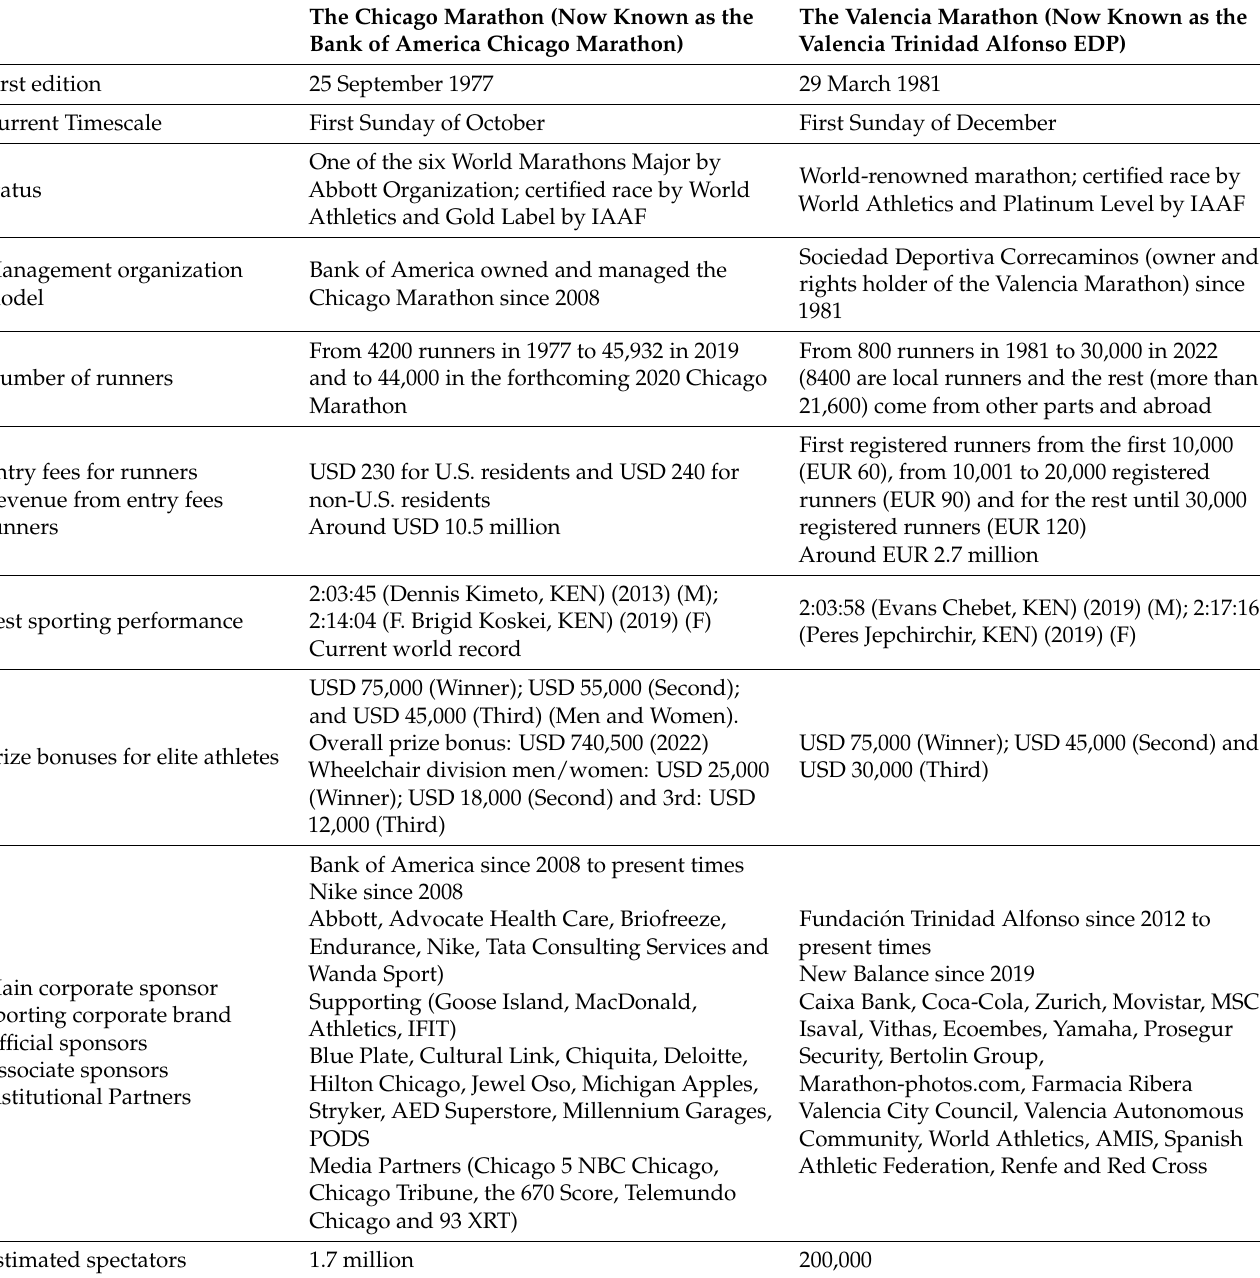
Table 2. Similarities and differences between both Chicago and Valencia Marathons in relation to management and financial factors since their first editions to current